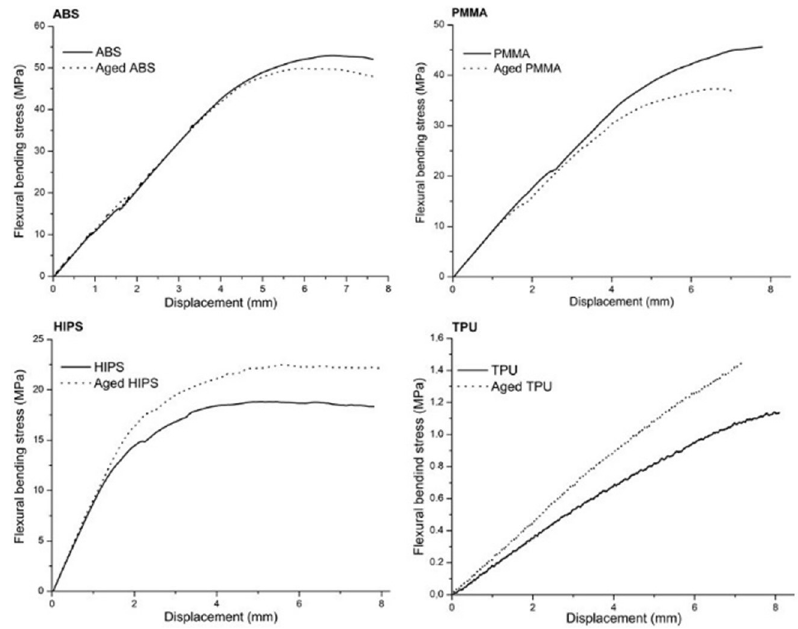
Figure 2. Stress–displacement curves that were obtained from the 3PB tests of the mono-materials. The plots show that both the dry and aged specimens presented curves with similar trends. However, the flexural bending stress and displacement values were different. The σ max of ABS and PMMA was lower for the aged specimens, while for HIPS and TPU, the opposite was observed (Figure